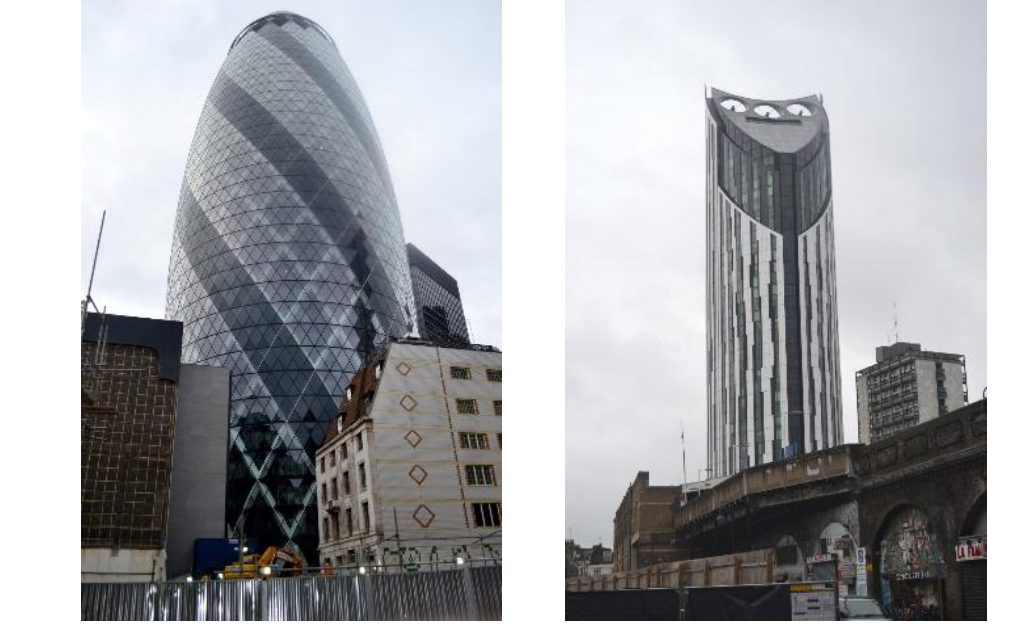
Strata SE1 Tower, London,